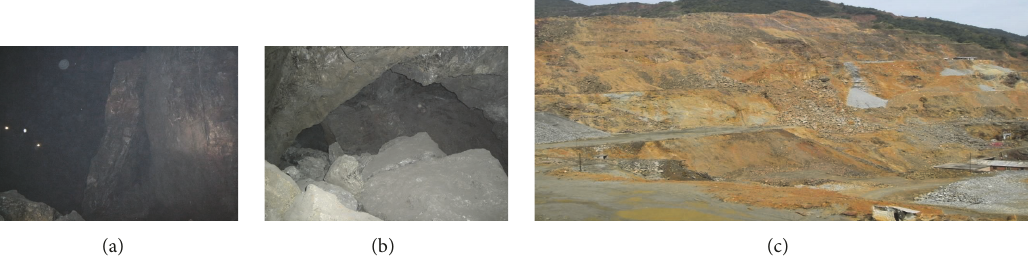
Figure 6: The distinct geostatic activities and scene of accident of Dabaoshan mine. (a) shows the pillar cracking phenomenon, (b) shows the large-scale falling in a underground goaf, and (c) shows the landslide accident caused by the collapse of underground